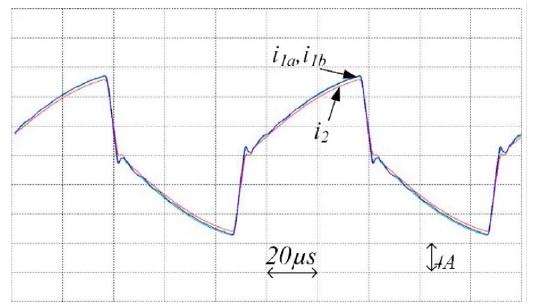
Figure 13. Currents through windings of the proposed system fed from PPSs emulating PV modules at the rated condition.